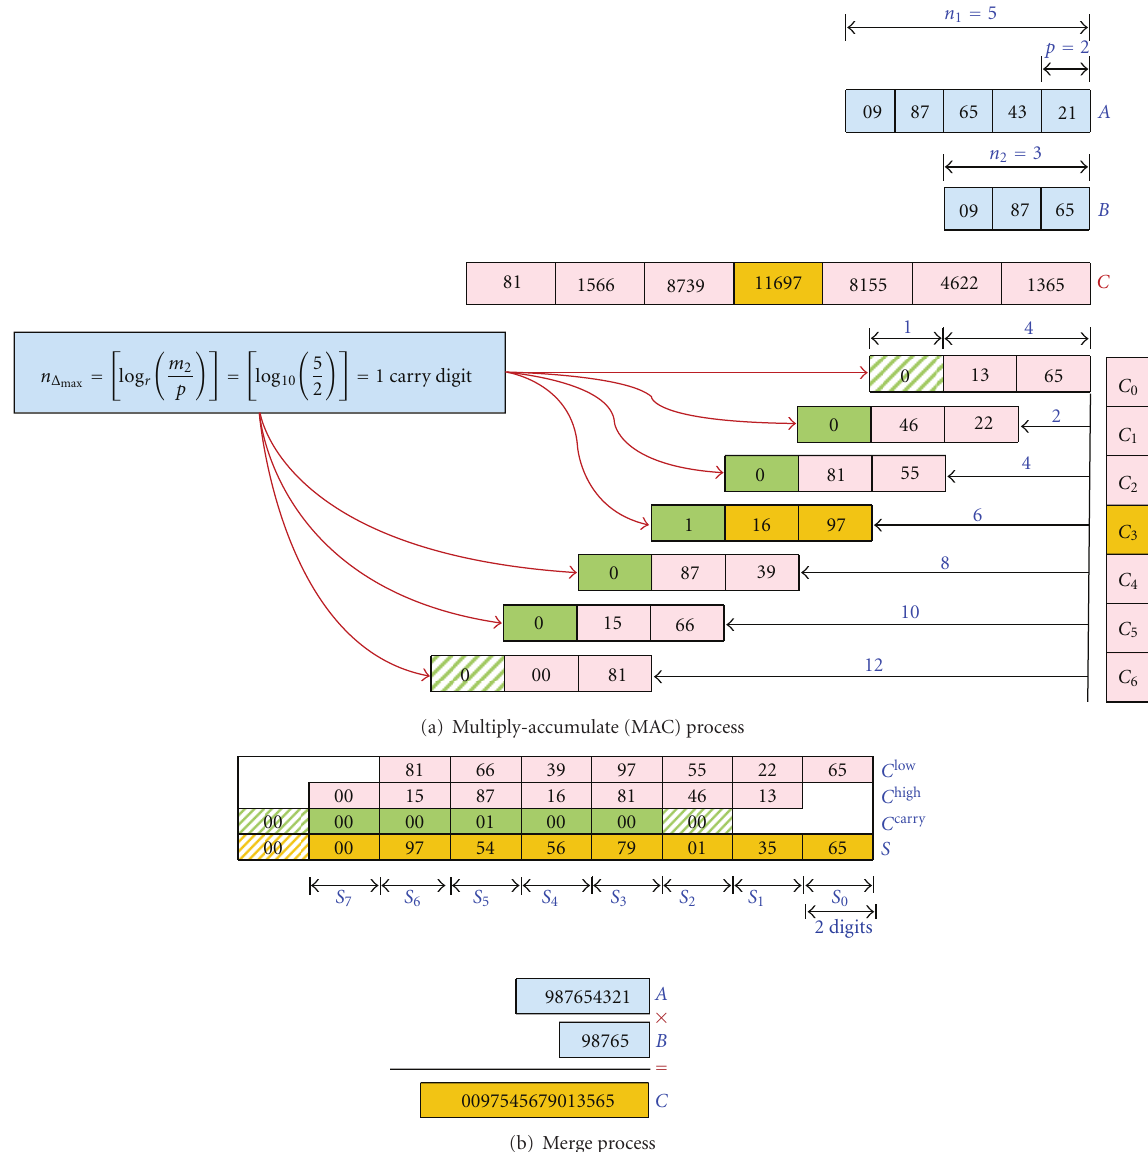
Figure 5: Example of decimal